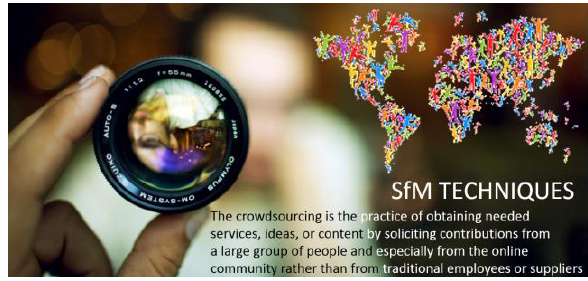
Figure 4. Crowdsourcing and SfM techniques